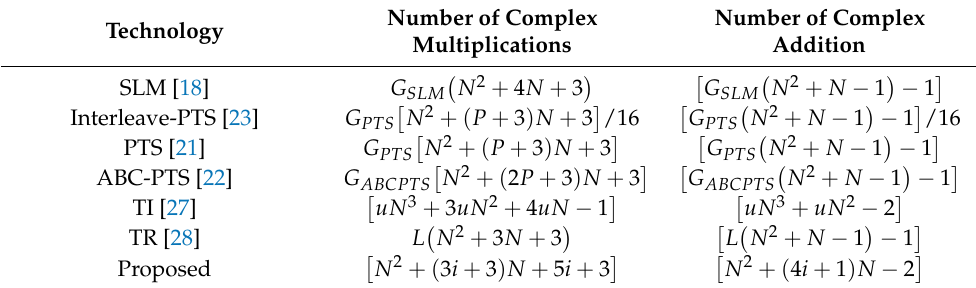
Table 3. Comparison of the computational complexity of the aforementioned